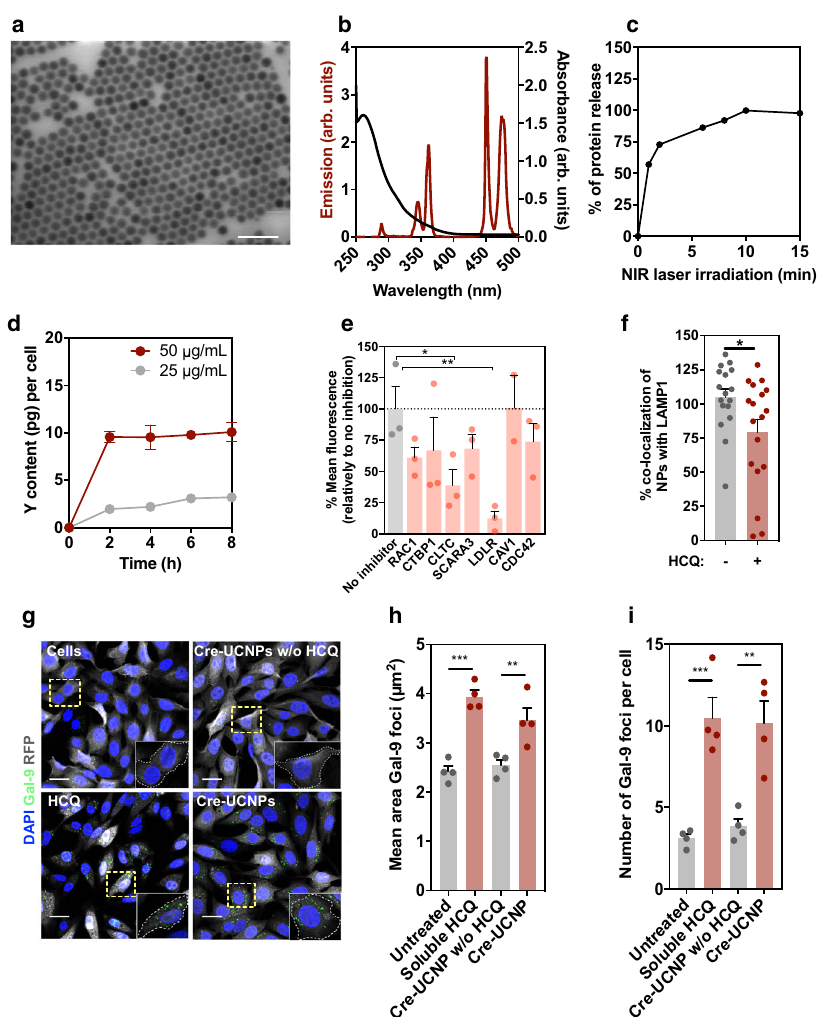
Fig. 2 Cellular uptake and intracellular traf fi cking of Cre-UCNPs. a Representative STEM image of Cre-UCNPs, obtained from a total of 5 images. Scale bar = 100 nm. b Luminescence emission spectrum of UCNPs (red) and absorption spectra of PCL (black). c Protein release from Cre-UCNPs (50 μ g/mL in PBS) was quanti fi ed by SDS-PAGE after activation by a NIR laser (785 mW/cm 2 ) for a speci fi c time. Results are expressed as Mean ± SEM ( n = 3 technical replicates). d Cellular uptake. Quanti fi cation of yttrium (Y) by ICP-MS in fi broblasts exposed to different concentrations of Cre-UCNPs for a speci fi c